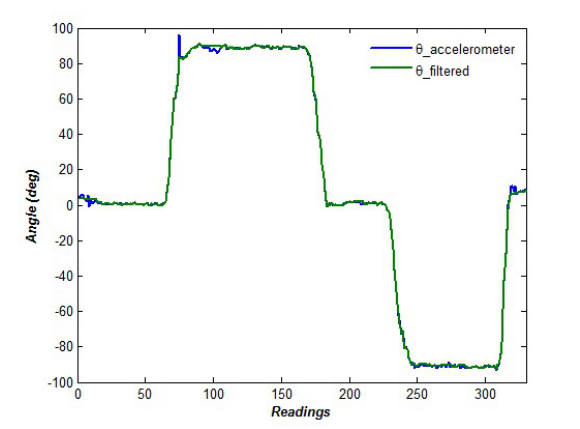
Figure 7: Filtered vs. accelerometer data in a dynamic